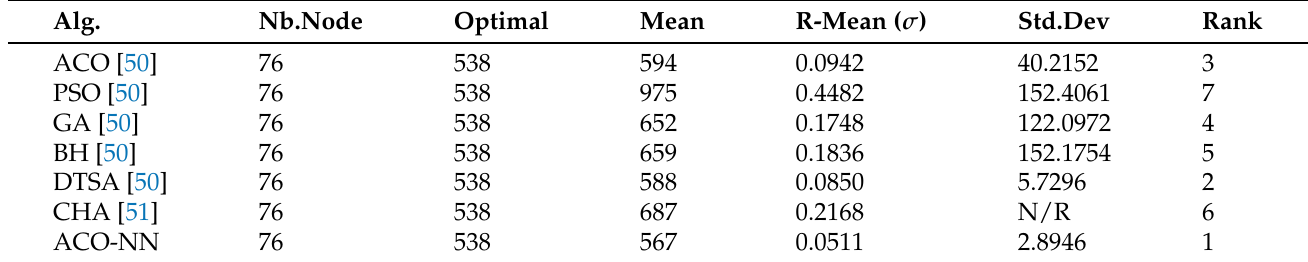
Table 5. Comparison of ACO-NN to various approaches for Eil76.